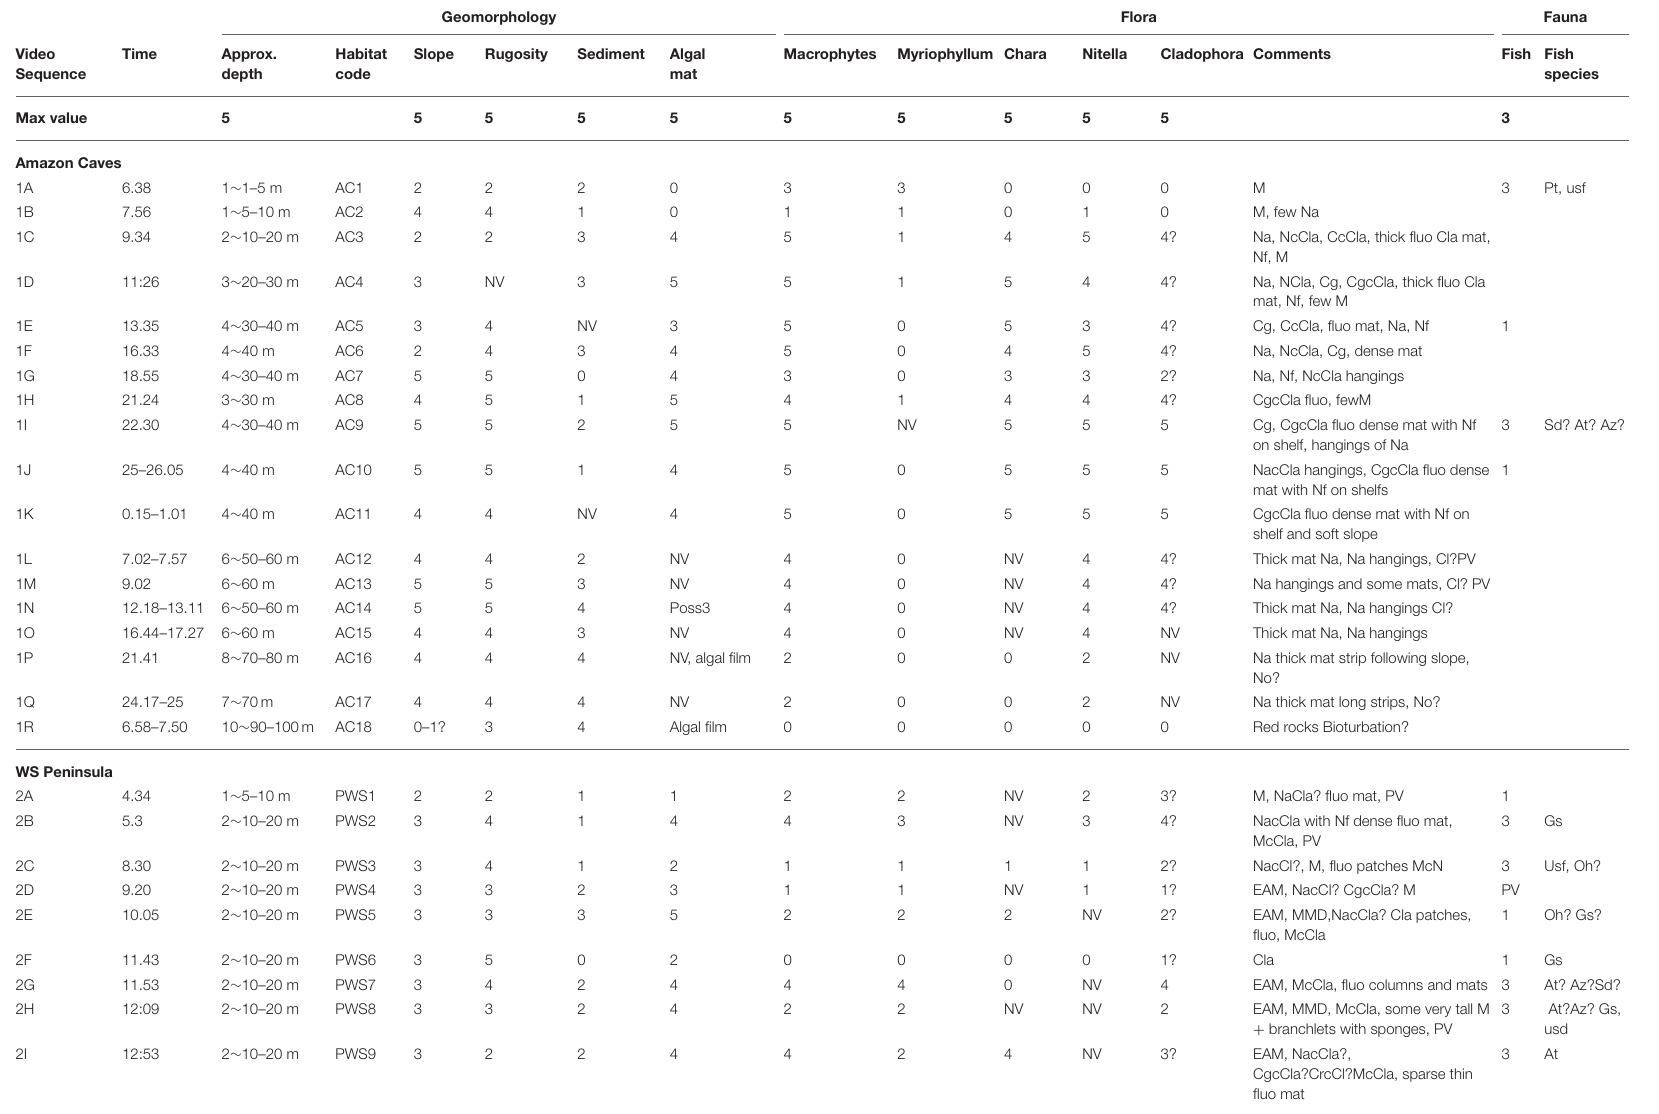
TABLE 1 | Results of analysis of the video sequences taken on bottom transects at two sites, Amazon Caves and Peninsula West Shore, using a GoPro 300 camera system, showing the geomorphological characteristics of the substrate and the most evident flora and fauna. Geomorphology Flora Fauna Video Time Approx. Habitat Slope Rugosity Sediment Algal Macrophytes Myriophyllum Chara Nitella Cladophora Comments Fish Fish Sequence depth code mat